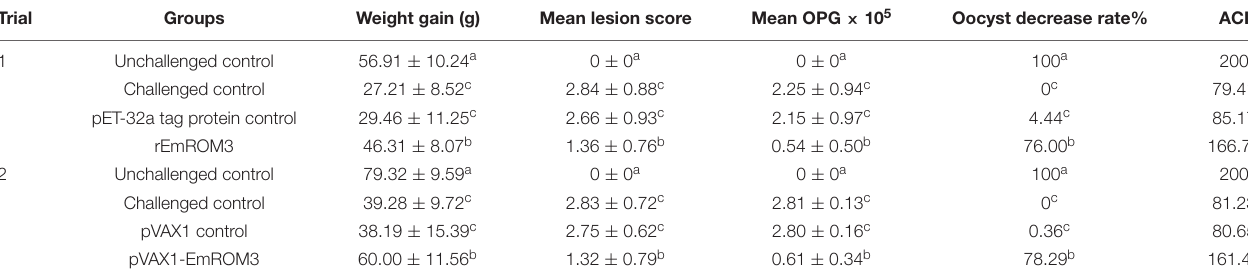
TABLE 2 | Protective efficacy of recombinant EmROM3 vaccines against E. maxima challenge.